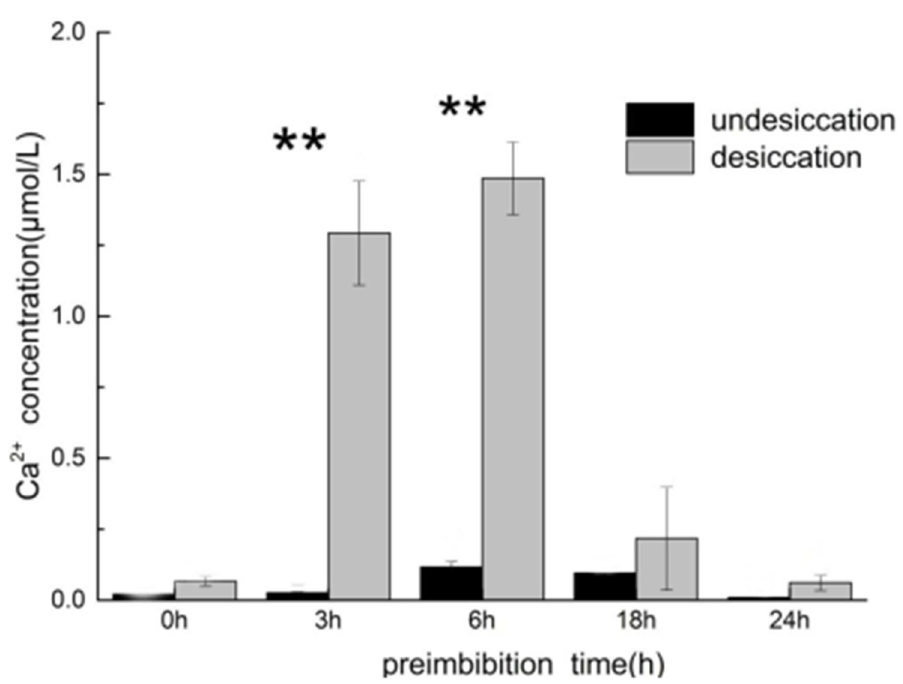
Fig 13. Concentration of cytoplasmic Ca 2+ in mung bean hypocotyl tissue in different preimbibition and dehydration states. �� P < 0.01.